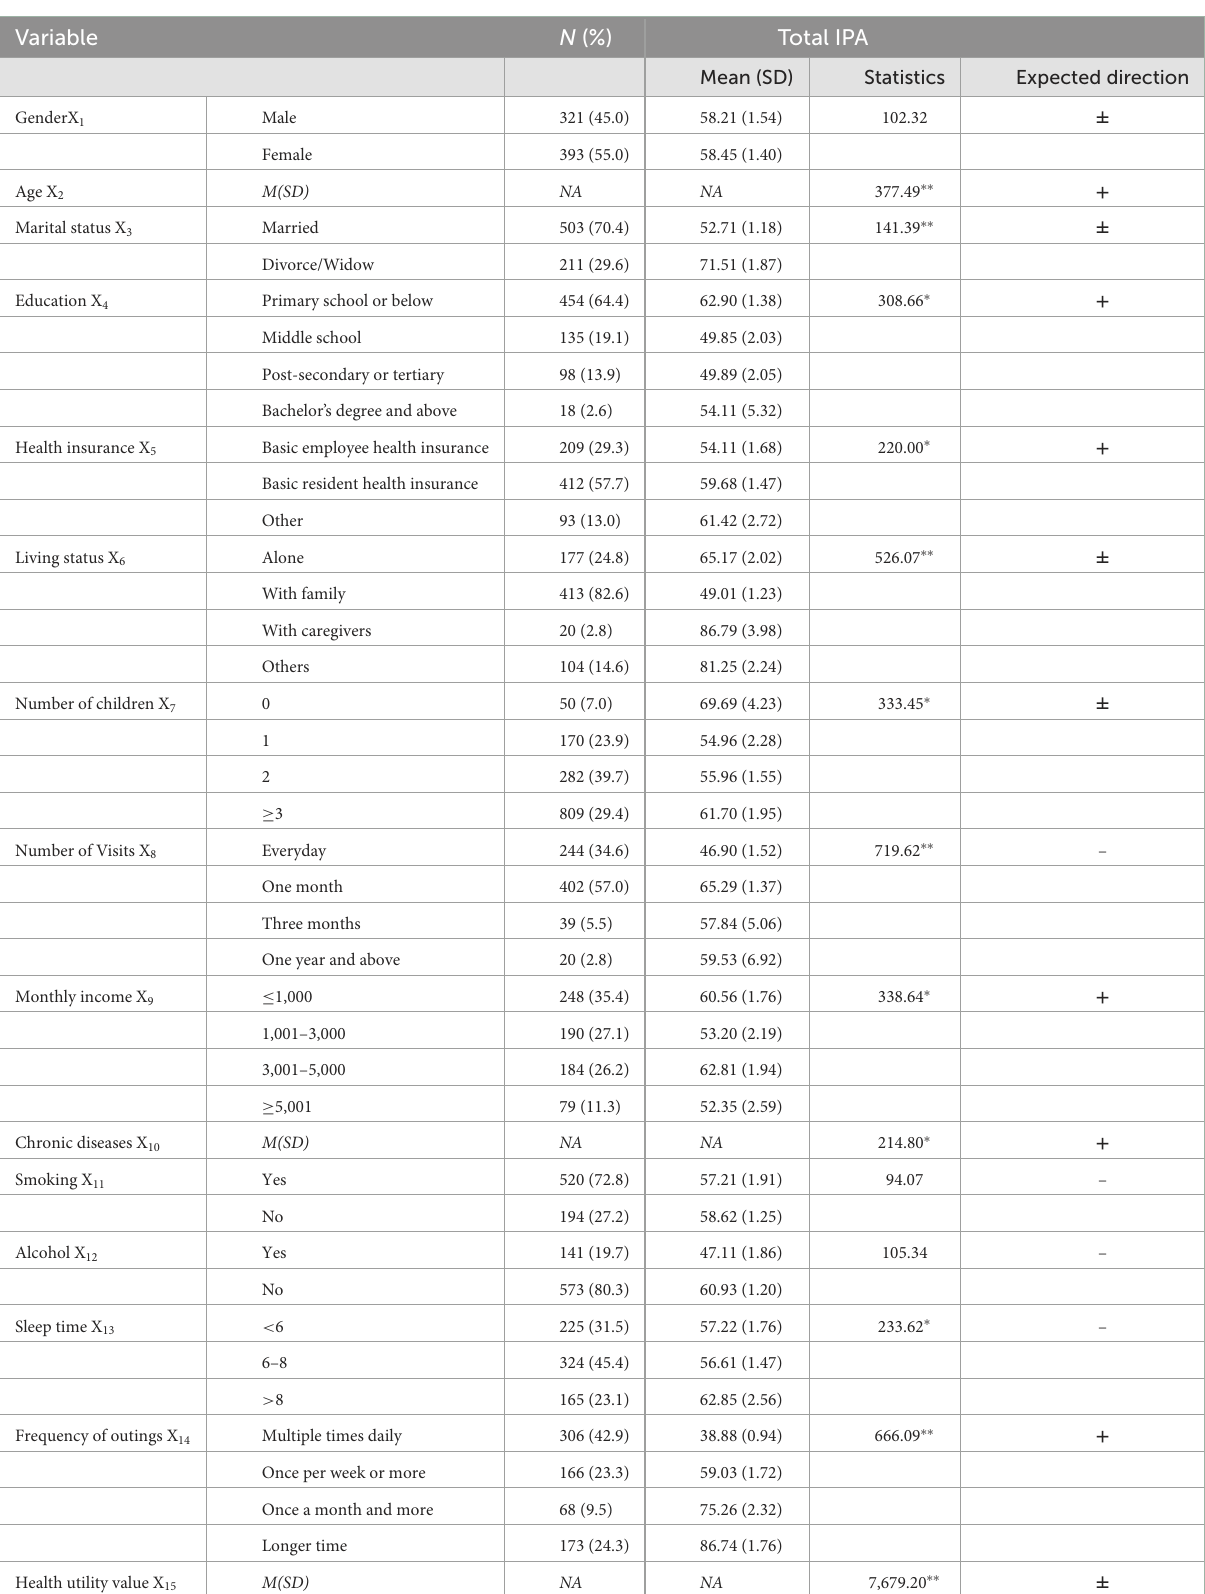
TABLE 1 Characteristics of participants and comparison of IPA scores among stroke survivors with different characteristics and expected